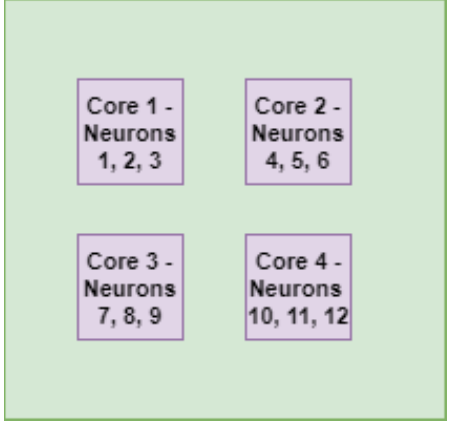
Figure 5. Direct mapping for four-cores